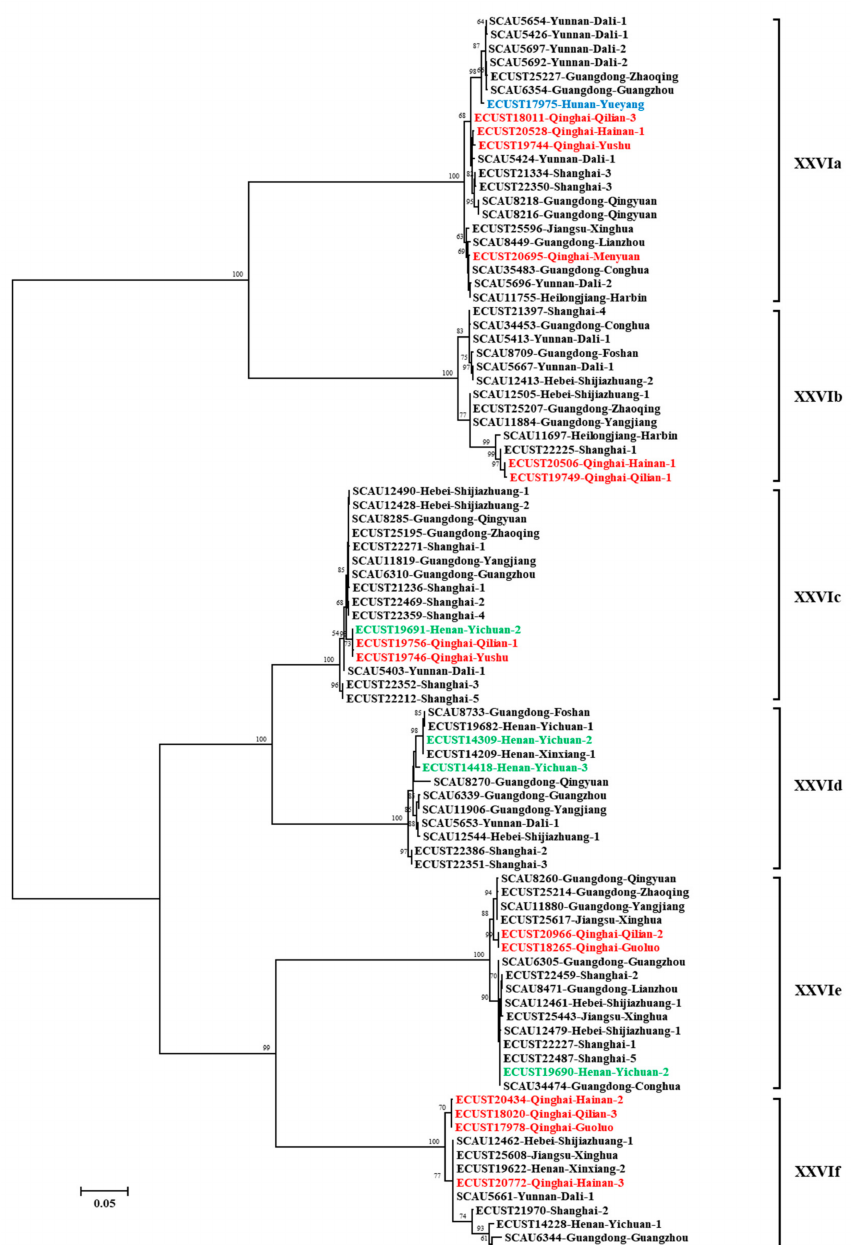
Figure 2. Phylogenetic relationship among six Cryptosporidium bovis subtype families (XXIVa–XXIVf) inferred by a maximum likelihood analysis of partial sequences of the gp60 gene. Sequences from dairy cattle, beef, yaks, and water buffalo are indicated by black, green, red, and blue characters, respectively. Bootstrap values greater than 50% from 1000 replicates are shown on branches. The scale bar equals 5 nucleotide substitutions per 100